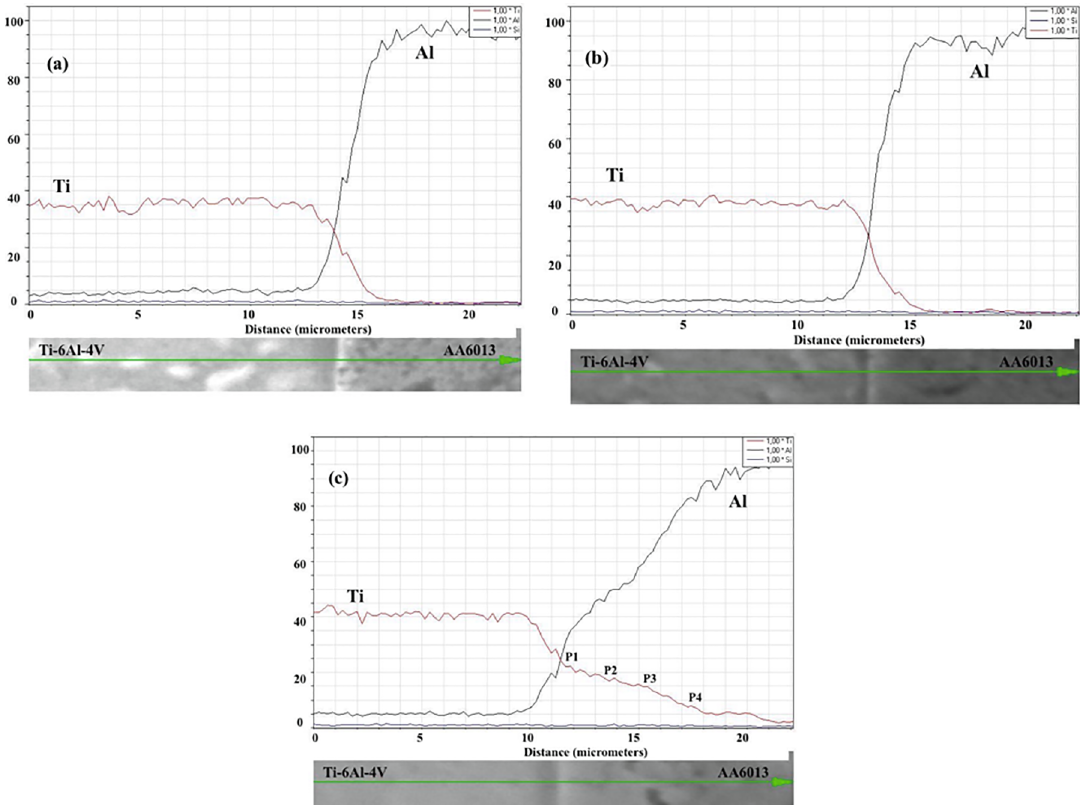
Figure 8. Distribution profile of Ti, Al and Si elements in the joining interface, comparing the effect of the silicon film deposited during (a) 1 hour and (b) 2 hours on Ti alloy, comparing with (c) a dissimilar joint without silicon film.